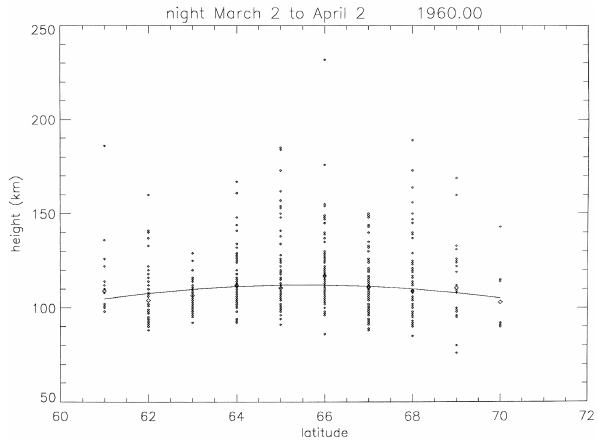
Fig. 8. Distribution if the height of the peak emission of 5577 ˚A [OI] emission as a function of dipole latitude for all of the 1960 ob- servations shown in Fig. 5a. The line is a second order polynomial least squares fit and the diamonds are median values.